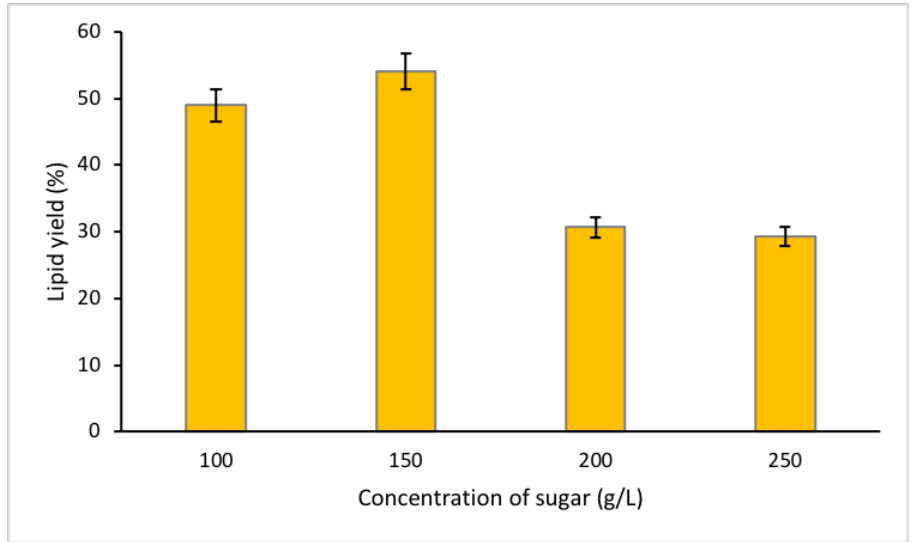
Figure 3. Percentage of lipid yield for different concentrations of sugar .